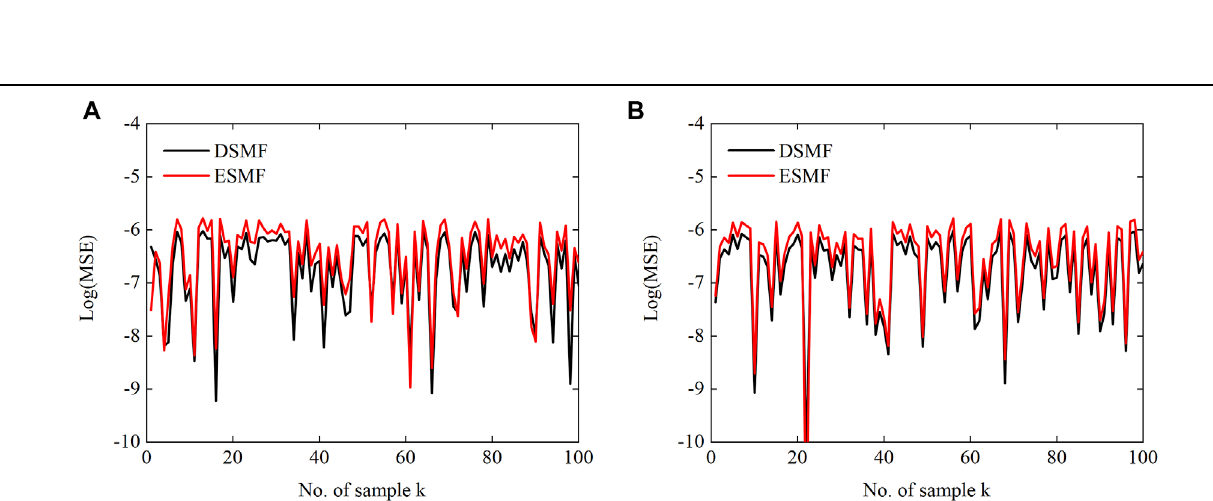
FIGURE 6 | Log(MSE) between the true and estimated values of a-phase at bus 4 for the DSMF and ESMF algorithms: (A) the real part of the voltage and (B) the imaginary part of the voltage.